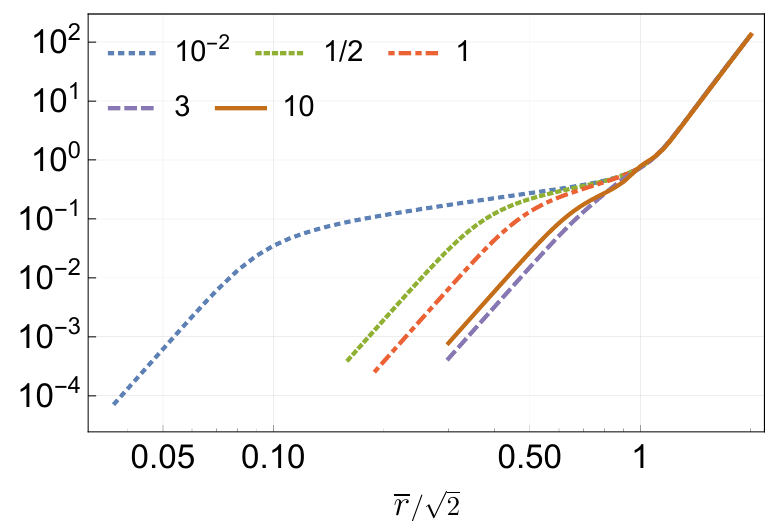
Figure 3. Relation between temperature and horizon position at (cid:12)xed values of the charge p density 2 N q